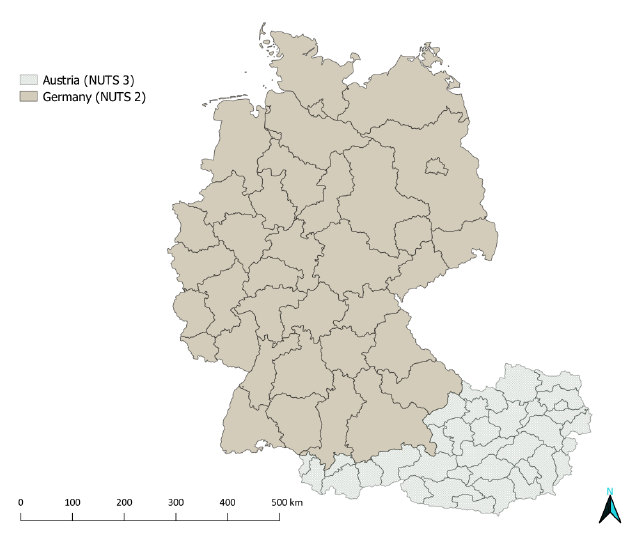
Figure E.1: NUTS regions used in the simulation.